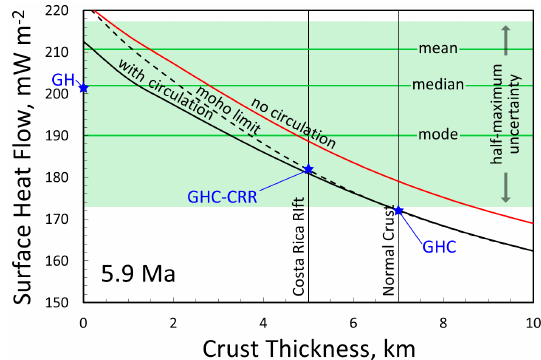
Figure 9. Predicted seafloor heat flow for model GHC with varied crust thickness and parameters affecting hydrothermal circulation are varied, compared to measured heat flow (mean, median, mode, and half-maximum bounds) for the Costa Rica Rift (Fig. 8). The black line is model GHC with oceanic crust varied between 0 and 10km. The black dashed line is the same model, except hydrother- mal circulation is not allowed to occur below the insulating layer. The red line is model GHC with the thickness of oceanic crust var- ied and no hydrothermal circulation on the ridge axis. All predic- tions are for 5.9My old